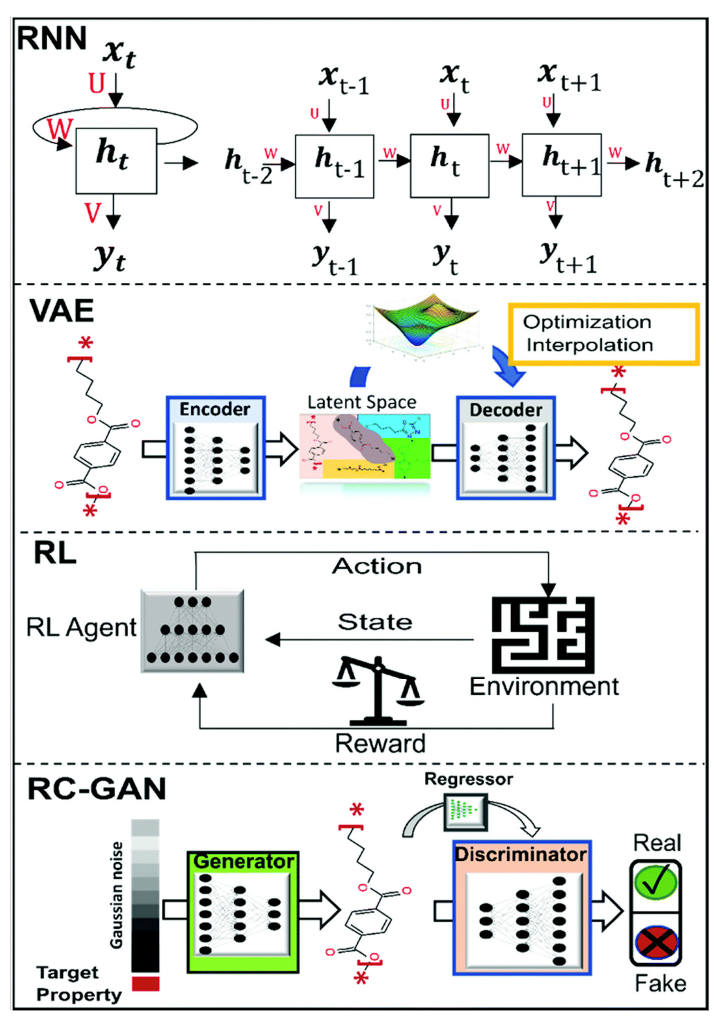
Figure 5. DL-based algorithms for GMs. (Reprinted with the permission from [41]).